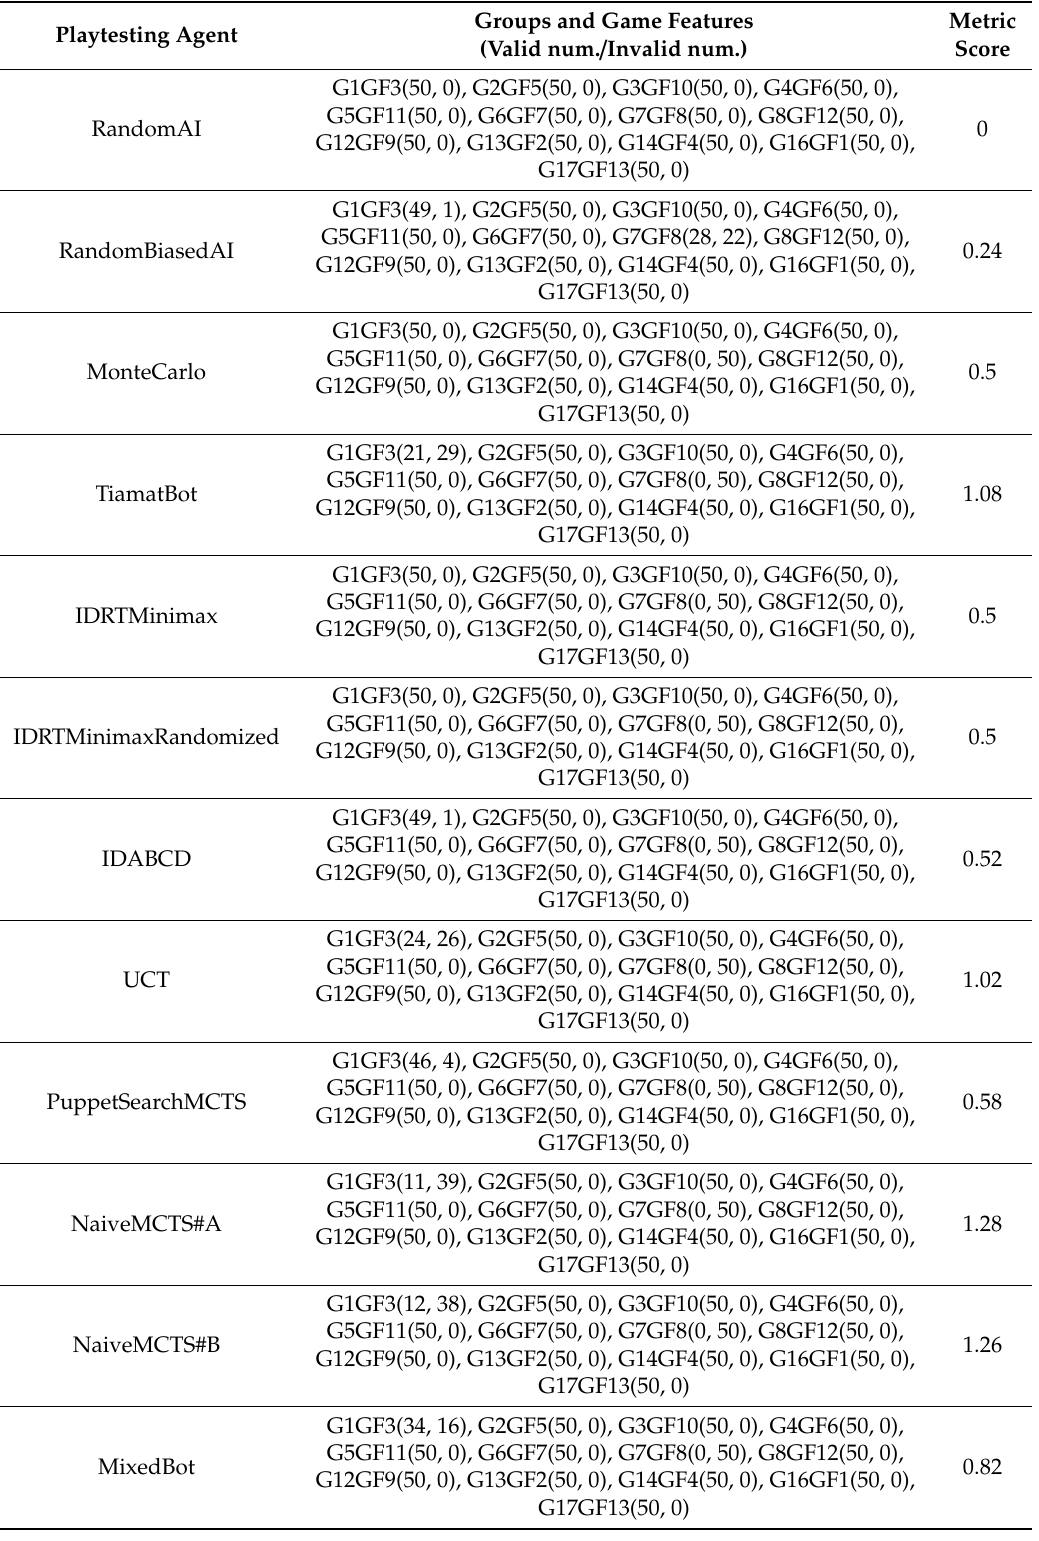
Table 6. Playtesting agent results for feature validations and their metric score. Groups and Game Features Playtesting Agent (Valid num. / Invalid